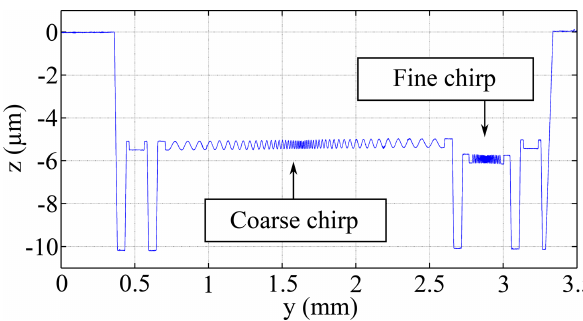
Figure 5. Profile of the PTB chirp standard measured by the tactile stylus instrument